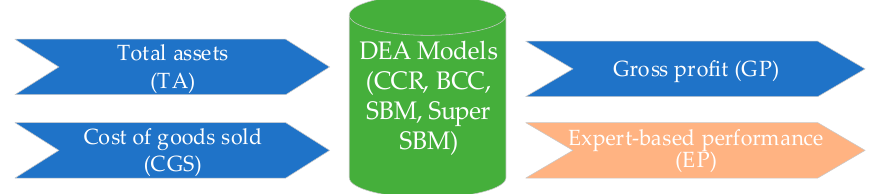
Figure 5. Data envelopment analysis model.